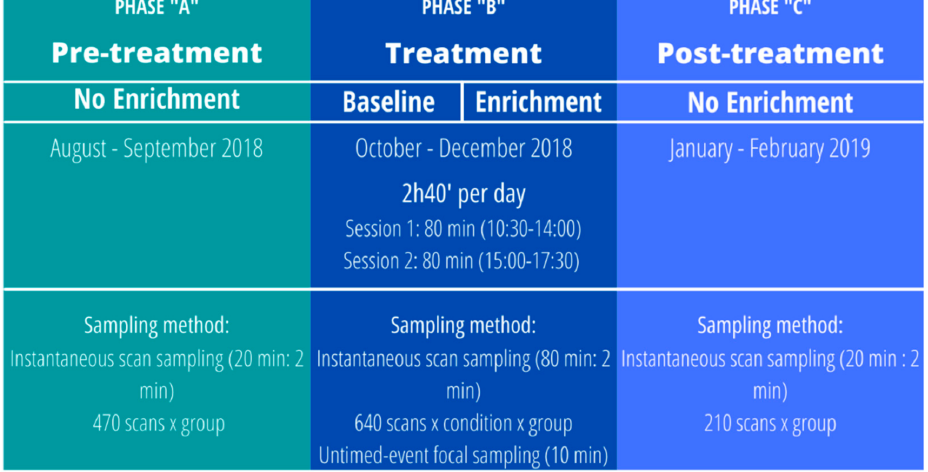
Figure 1. Structure of the experimental design and